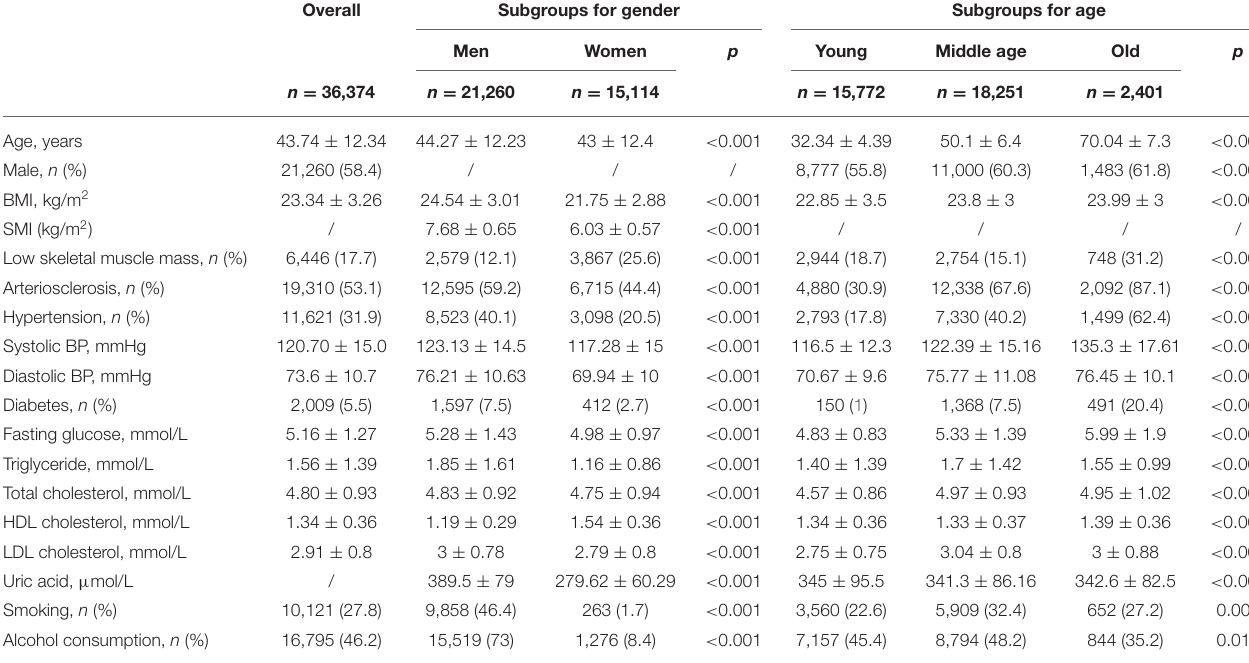
TABLE 2 | Comparisons between subjects with and without arteriosclerosis.